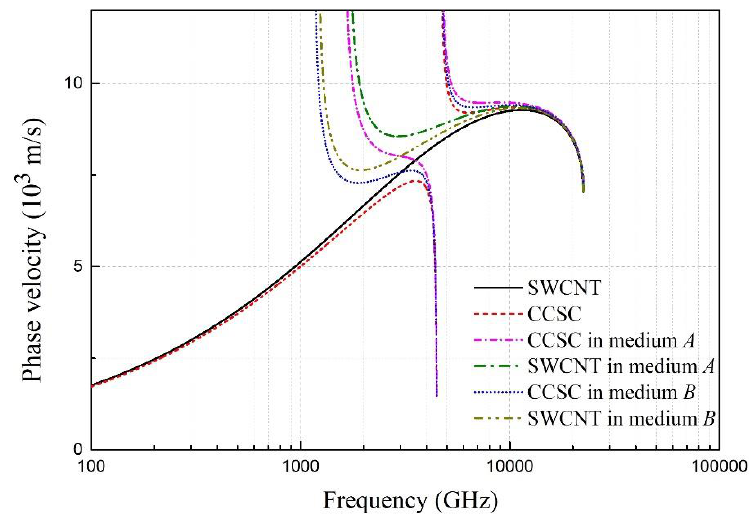
Figure 9. The phase velocity of the flexural wave versus the frequency of the SWCNT and the CCSC the elastic in the elastic medium.